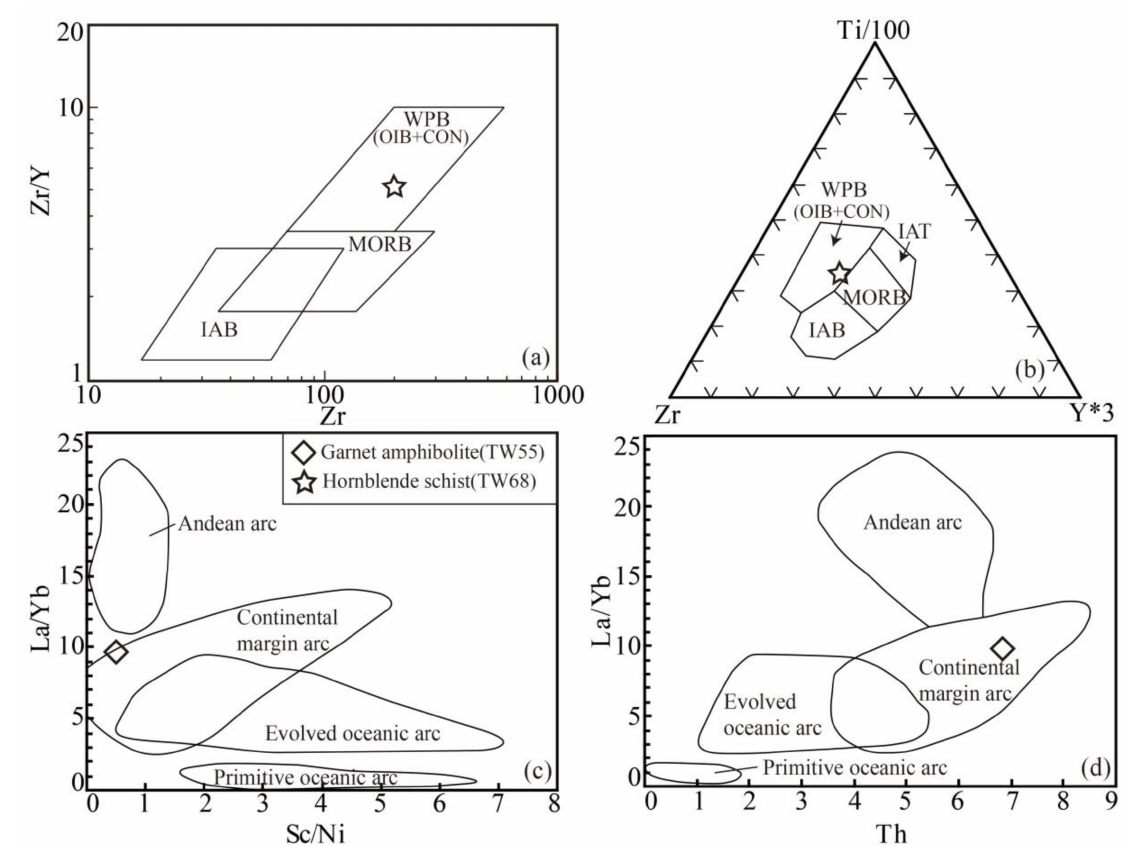
Figure 8. Trace element discrimination diagrams of meta-igneous rocks from the Wuguan Complex. ( a ) Zr/Y-Zr diagram (after [68]). ( b ) Ti/100-Zr-Y*3 diagram (after [69]). ( c ) La/Yb-Sc/Ni diagram (after [70]). ( d ) La/Yb-Th diagram (after [70]). Abbreviations: within-plate basalt (WPB), ocean